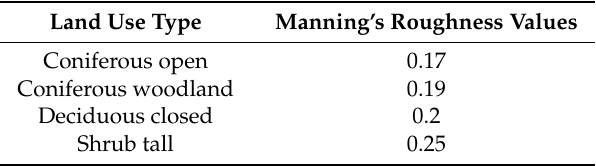
Table 3. Manning’s roughness values.